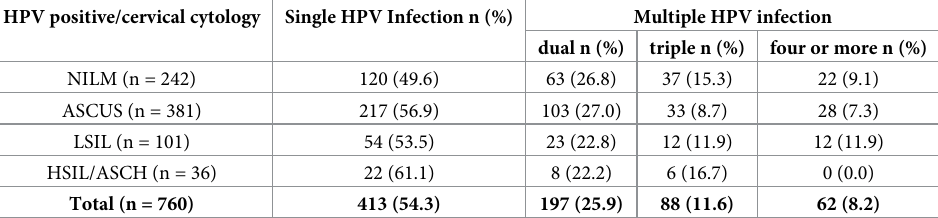
Table 4. Frequences of single and multiple infections by cytological groups.